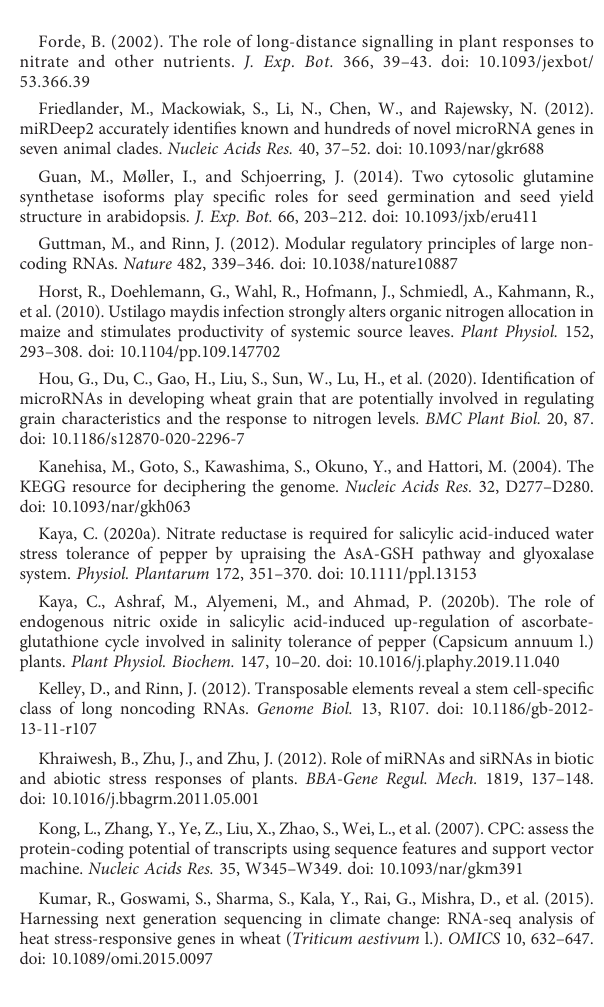
pathway, and the abscissa represents the enrichment factor. The larger the enrichment factor, the more signi fi cant the enrichment level of DEGs in the pathway. (B) Histogram of KEGG enrichment analysis. Only KEGG pathways with enriched DEGs greater than or equal to 4 are listed. The numbers in the fi gure represent the number and percentage of DEGs enriched in each KEGG pathway. SUPPLEMENTARY FIGURE 7 Validation of the expression patterns of randomly selected differentially expressed lncRNAs and differentially expressed miRNAs by qRT-PCR. The column represents the relative expression levels of qRT-PCR, and the broken line the log2(fold change) of RNA-seq or small RNA-seq. SUPPLEMENTARY FIGURE 8 Expression of important DEGs in the lncRNA-miRNA-mRNA regulatory module in different tissues of wheat and under various abiotic stresses. (A) Expression of DEGs in different tissues of wheat. (B) Expression of important DEGs under low phosphorus stress. (C) Expression of important DEGs under cold stress. (D) Expression of important DEGs under heat stress. (E) Expression of important DEGs under salt